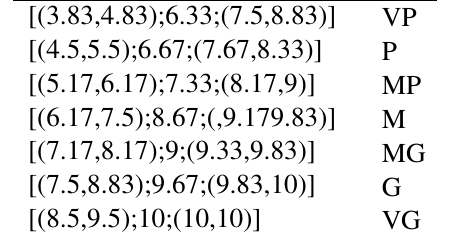
Table 6 Interval fuzzy value of linguistic